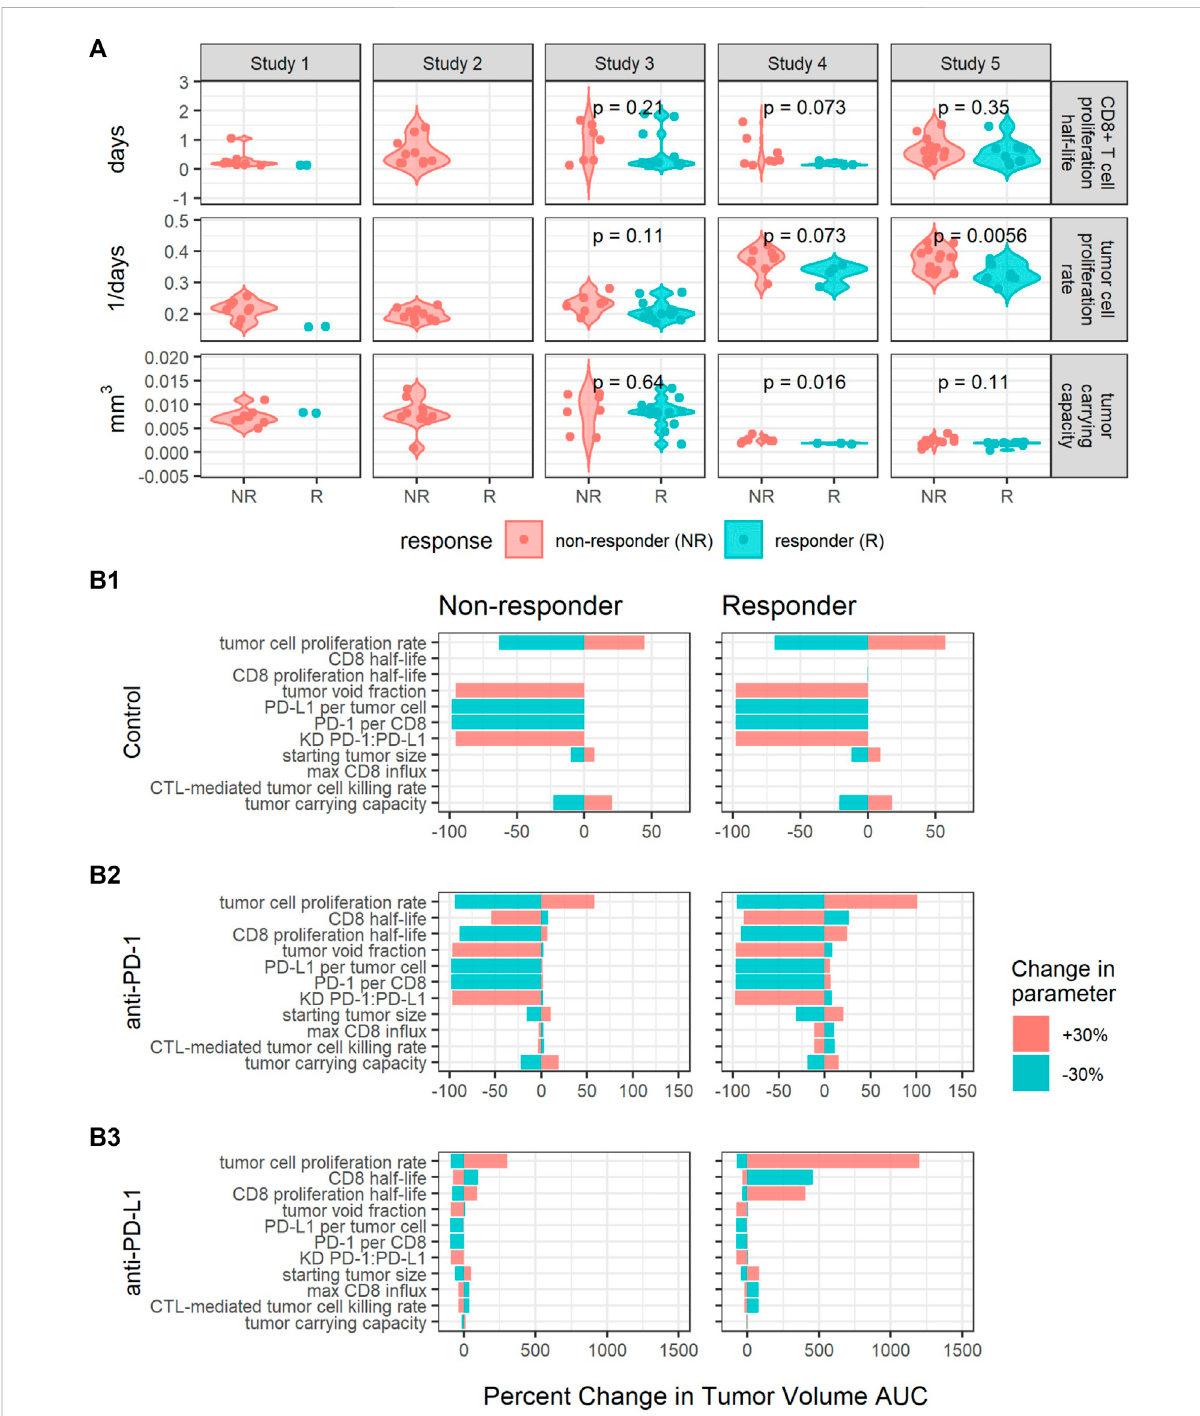
FIGURE 4 Perturbations in key parameters change individual mice ’ s responses. (A) Comparisons of CD8 + T cell proliferation half-lives, tumor cell proliferation rates, and tumor carrying capacities between responders (R) and non-responders (NR) for each study. p -values were calculated using theWilcoxonranksumtest. (B) Localsensitivityanalysiscenteredonparameterssets fi ttoaresponderandanon-responderfromStudy5forcontrol (B1) , anti-PD-1 (B2) and anti-PD-L1 (B3) simulations. Model output is summarized as the percent changes in the area under the tumor volume curve (AUC) over 30 days. The parameters are listed in the order of decreasing sensitivity across all